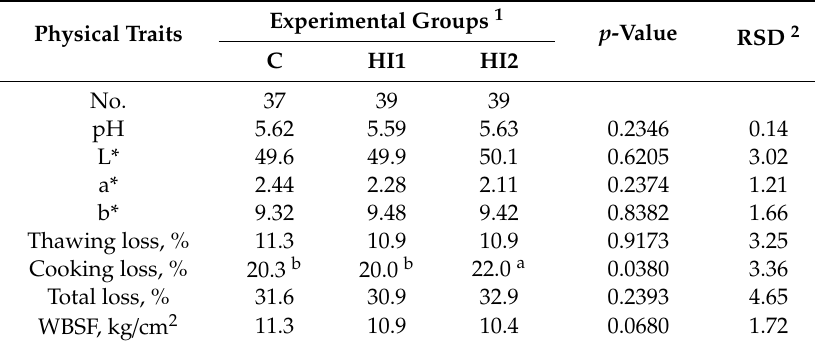
Table 2. E ff ect of the dietary inclusion of Hermetia illucens dried larvae farmed on di ff erent growth substrates (HI1, HI2) on the physical traits of broiler quails’ breast meat.